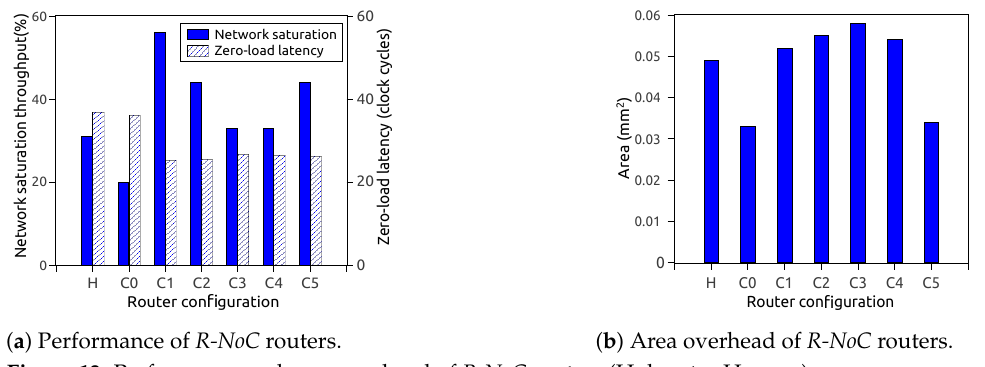
Figure 13. Performance and area-overhead of R-NoC routers (H denotes